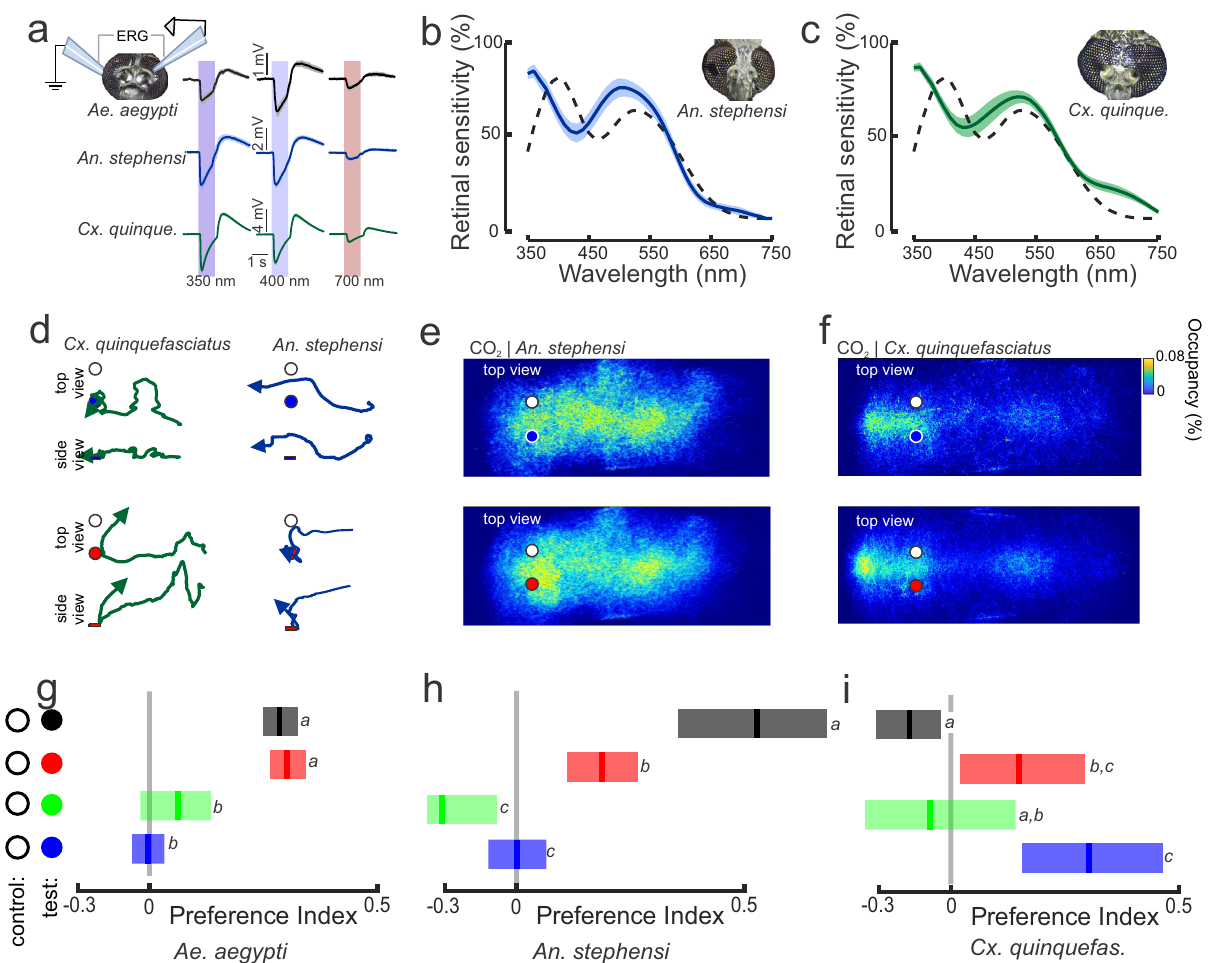
Fig. 7 Species-speci fi c responses to dominant wavelengths. a Electroretinogram (ERG) recordings from Ae. aegypti , An. stephensi and Cx. quinquefasciatus mosquitoes. Each trace is the mean ± sem of 7 – 9 mosquitoes/species. b , c Retinal sensitivity to discrete wavelengths show that both An. stephensi ( b ) and Cx. quinquefasctiatus ( c ) have the strongest responses in the UV (360 nm) and green (520 nm) bands. The dashed line is the retinal sensitivity of Ae. aegypti . d Representative fl ight trajectories [(x,y) and (x,z)] of Cx. quinquefasciatus (left) and An. stephensi (right) mosquitoes. Cx. quinquefasciatus showed a mild attraction to the blue object (top), whereas An. stephensi showed an attraction to the red object (bottom). e , f Occupancy maps (x,y) of An. stephensi ( e ) and Cx. quinquefasciatus ( f ) distribution around the 452 nm (top) and 660 nm (bottom) objects during CO 2 exposure. g – i The preference indices for Ae. aegypti ( g ), An. stephensi ( h ) and Cx. quinquefasciatus ( i ) in response to the black, 660 nm (R-Hue), 510 nm (Gc-T1), and 452 nm (Bw-T1) objects. Lines are the means and shaded bars are the 95% con fi dence intervals, and letters above bars denote statistical comparisons (Kruskal – Wallis test with multiple comparisons: P < 0.05) (for Ae. aegypti , n = 29,254; 13,580; 18,190; and 12,086 trajectories; for An. stephensi , n = 5817; 9134; 2153; and 5627 trajectories; and for Cx. quinquefasciatus , n = 3746; 13,553; 4238; and 2835 for black, 660 nm, 510 nm, and 452 nm treatments, black and 660 nm objects (Fig. 7h; Kruskal – Wallis test: df = 3, Chi-square = 38.6, P < 0.001), but they were not signi fi cantly